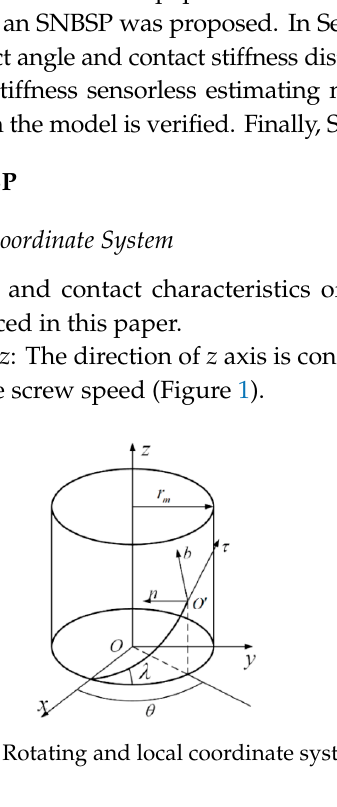
Figure 2. Coordinate systems. The transformation relationship between the rotating coordinate system CS Oxyz and the local coordinate system CS O nb τ′